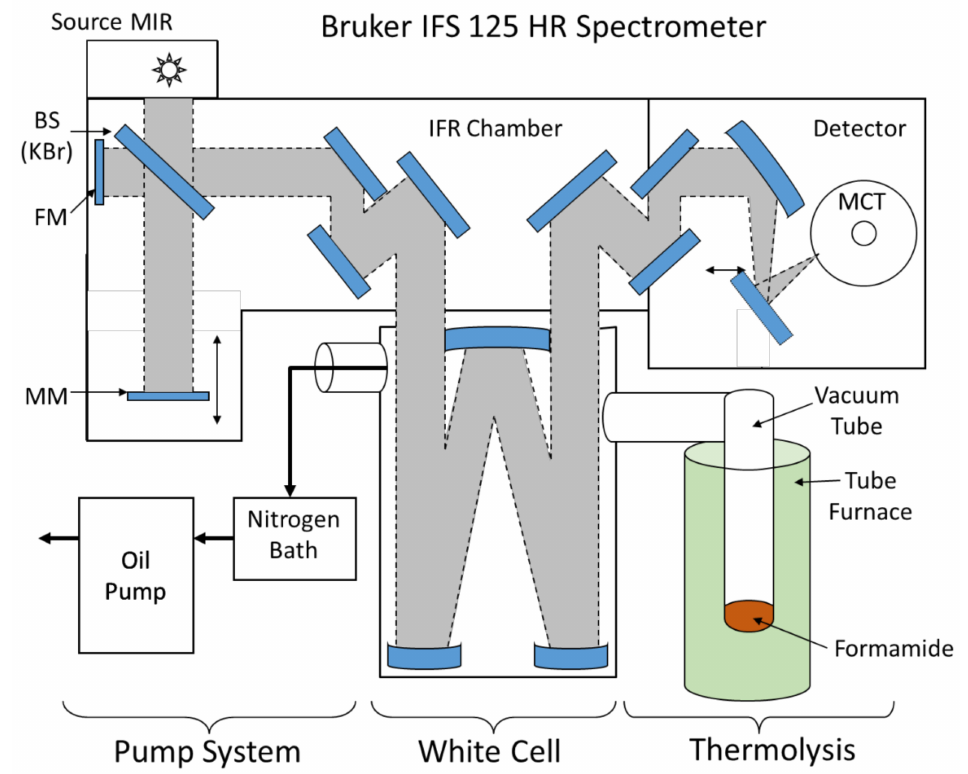
Figure 6. Scheme of the setup used for the inspection of gas phase products formed in the formamide thermal decomposition experiment. BS: beamsplitter, IFR: interferometer, MM: mobile mirror, FM: fixed mirror. Thermolysis was conducted in a vacuum sealed tube inserted in tube